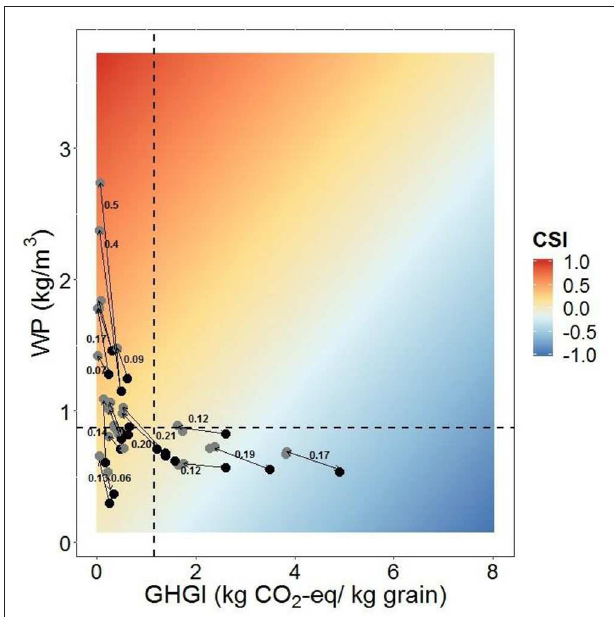
FIGURE 3 | Scatterplots of the relationship between Global Warming Potential (GHGI) and Water Productivity (WP) plotted over a heat map indicating CSI values. Gray circles represent AWD treatments and black circles Continuous flooding treatments. The arrows link paired treatments from the same studies and the numbers close to the arrows indicate the CSI difference between them. The vertical dotted line represents the mean GHGI of studies in the dataset and horizontal dotted line, the mean